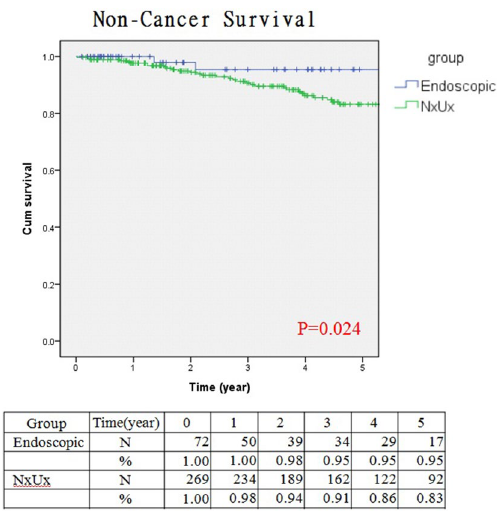
Figure 4. Kaplan–Meier survival curves of non-cancer survival stratified by endoscopic or nephroureterectomy management. (Survival curves were created and analyzed by SPSS software version